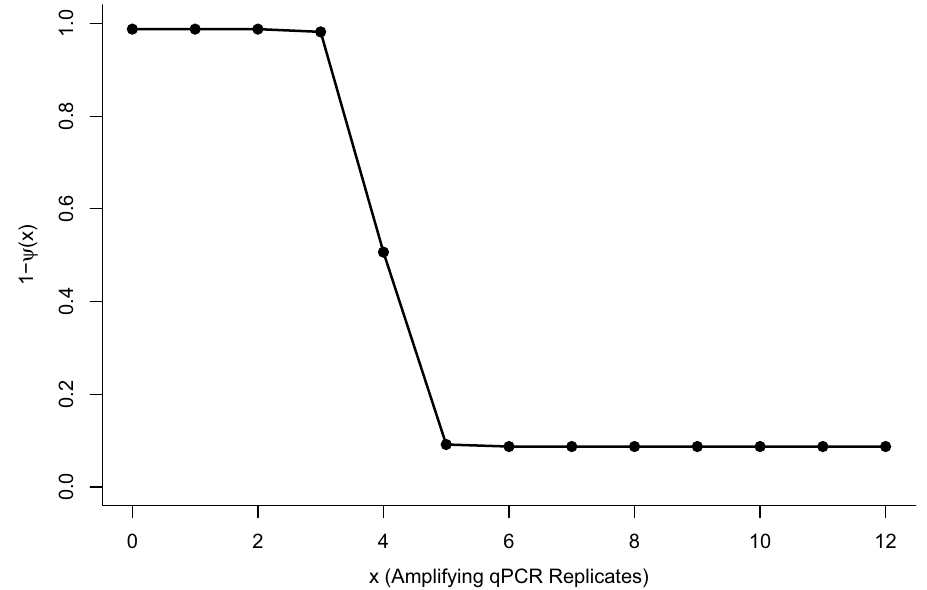
Figure 3. The posterior conditional probabilities of species absence (1—ψ (x)), given x amplifying qPCR replicates.